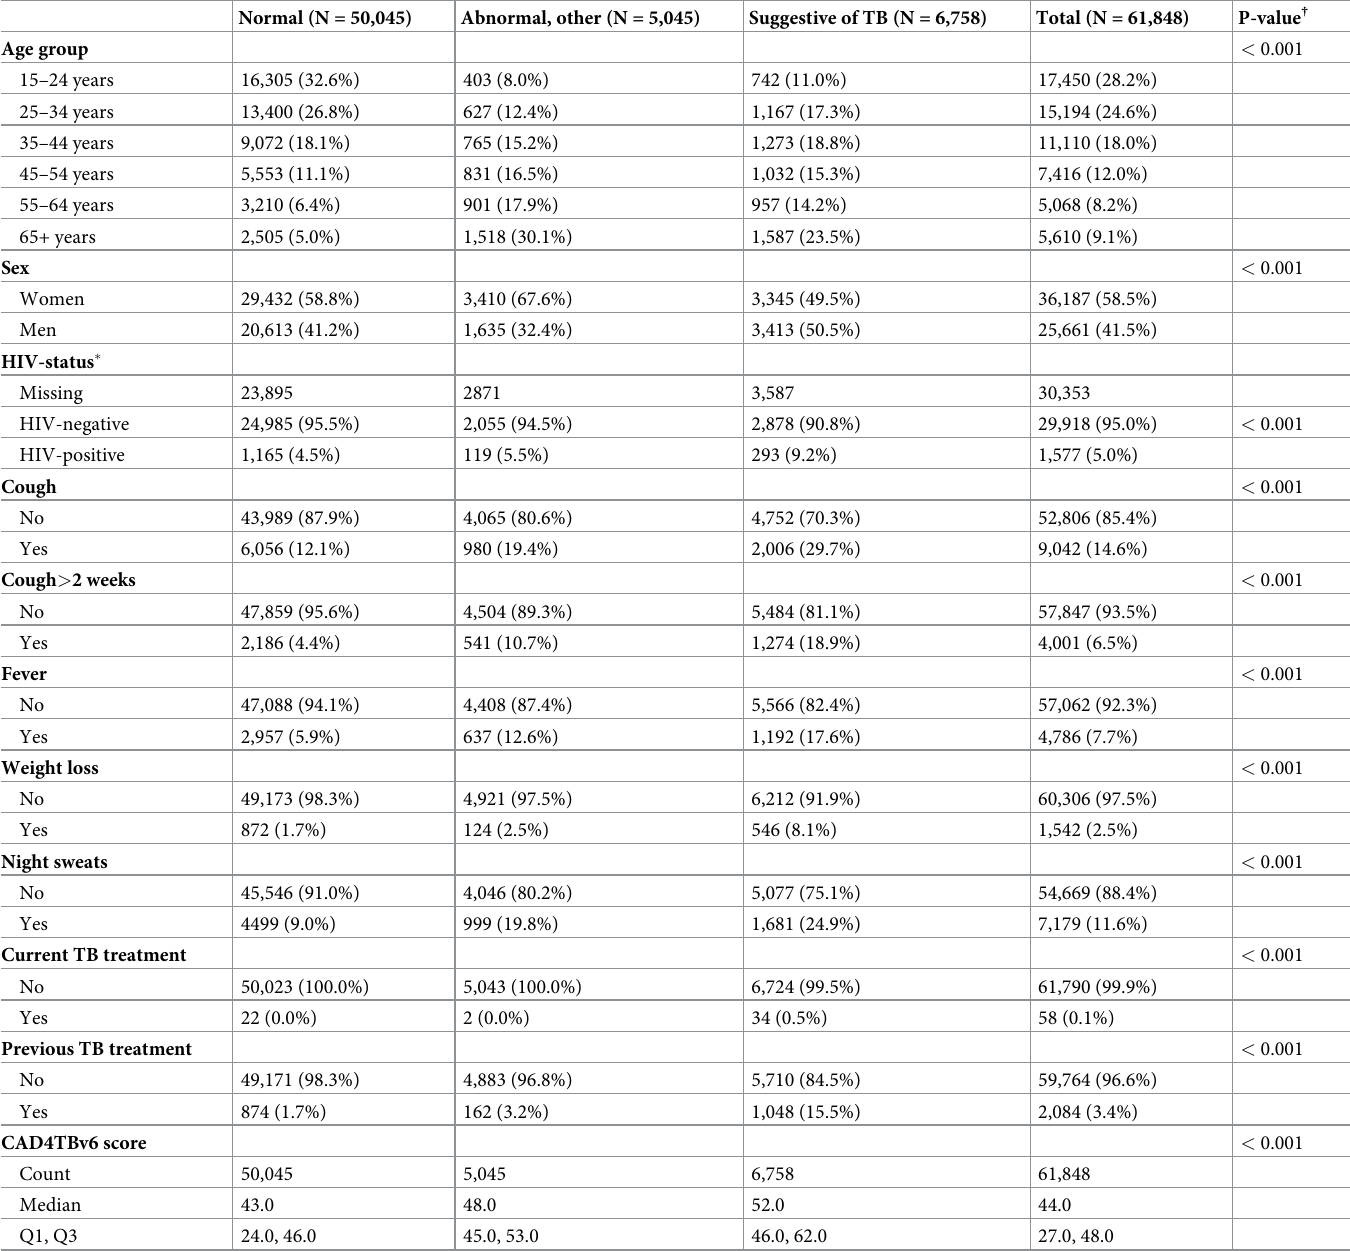
Table 1. Characteristics of participants in Kenya National TB prevalence survey, by clinical officer chest X-ray